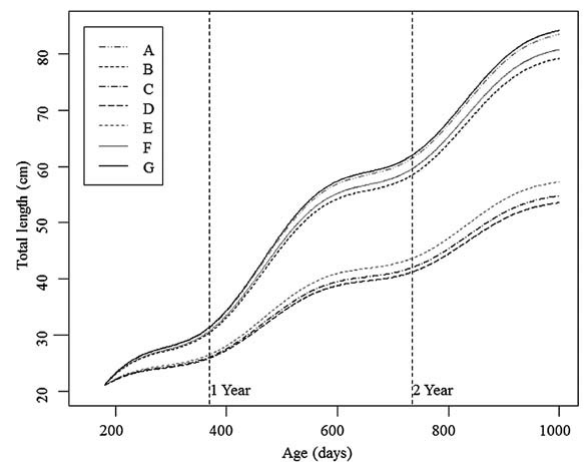
Fig. 2. – Estimated growth of A. regius juveniles for the seven tested diets during the grow-out phase.